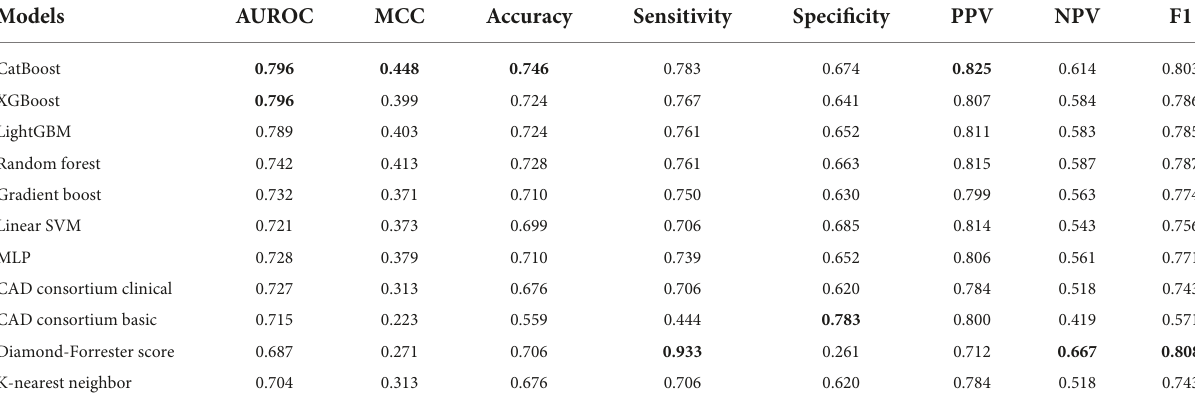
TABLE 2 Comparison of performance between risk prediction models.